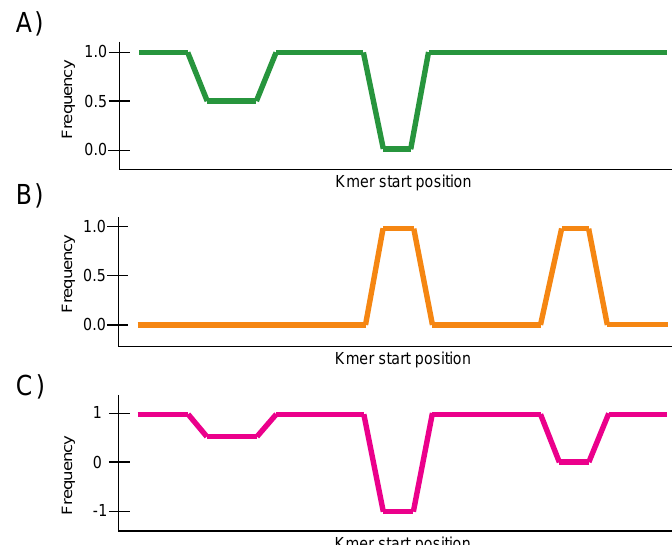
Figure 2. Schematic representation of a differential landscape between two groups. ( A ) The conservation landscape for group 1 target genomes. ( B ) The conservation landscape for group 2 target genomes. ( C ) The differential landscape between group 1 and 2. The differential landscape is obtained by subtracting conservation at group 2 from conservation at group 1. The differential landscape goes to 1 when conservation is 1 in group 1 and 0 in group 2. In contrast, the differential landscape goes to − 1 when conservation is 0 in group 1 and 1 in group 2.